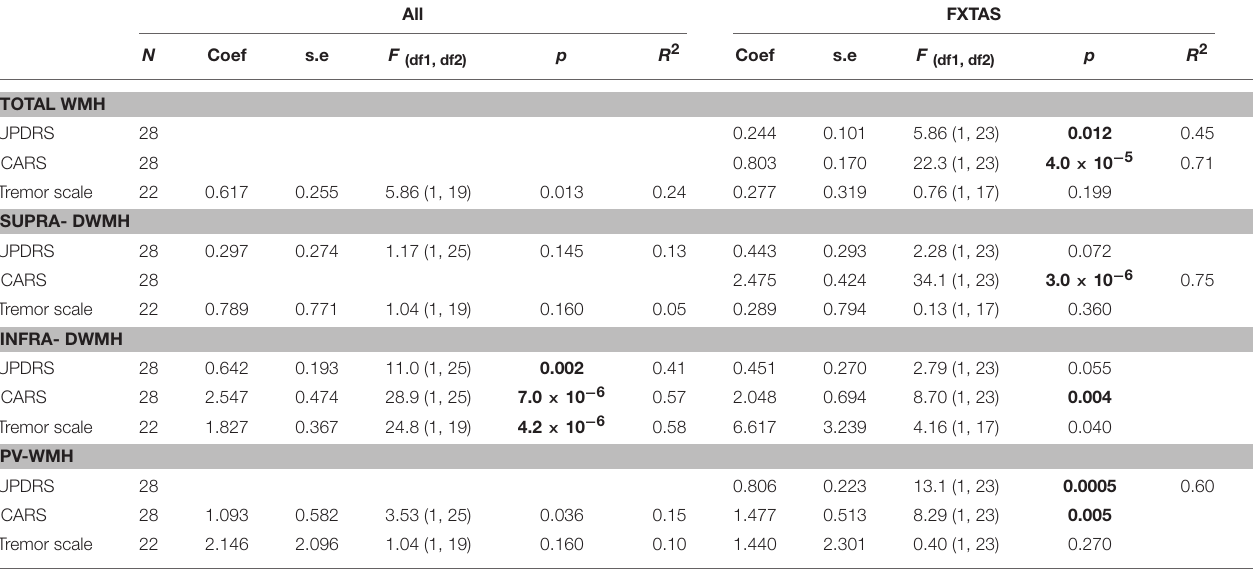
TABLE 2A | Relationships between each motor score (outcome) and each wmhs score (predictor), adjusted for age, and the FXTAS group.